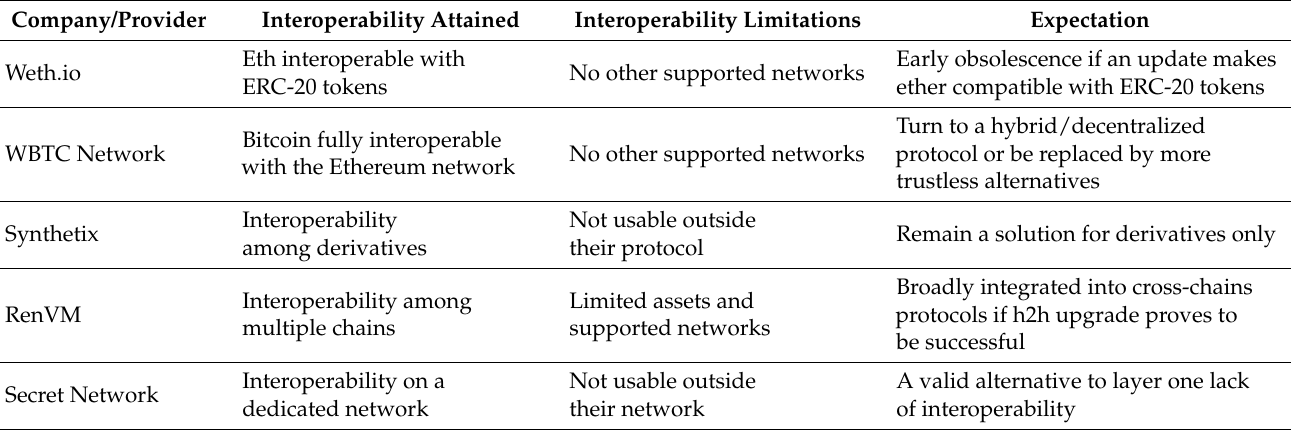
Table 9. Interoperability